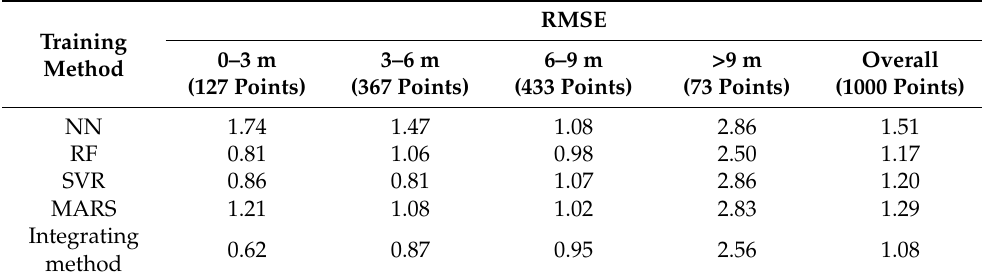
Table 1. A comparison of the root-mean-square error (RMSE) errors for different water depths and machine learning methods.